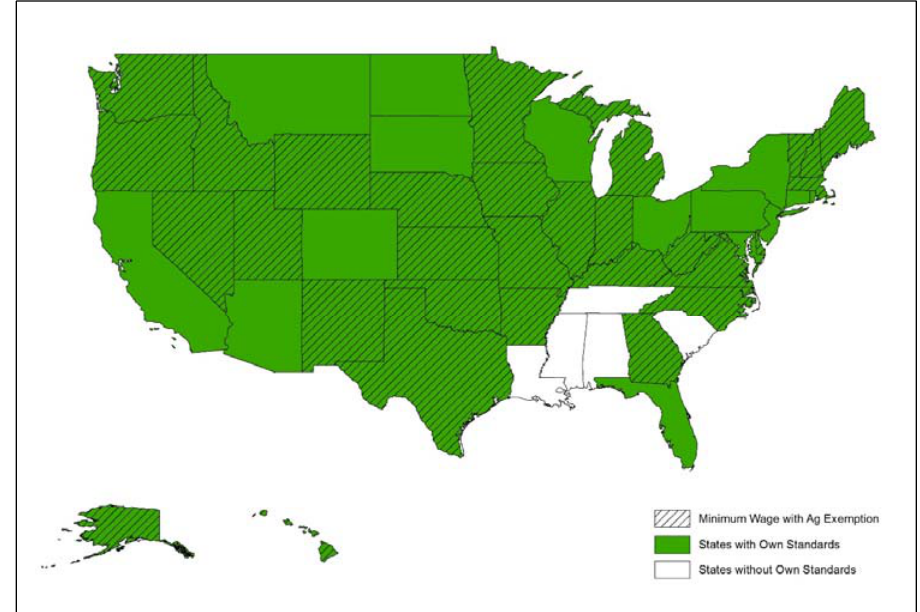
Figure 1. Minimum Wage Agricultural Exceptions by State,